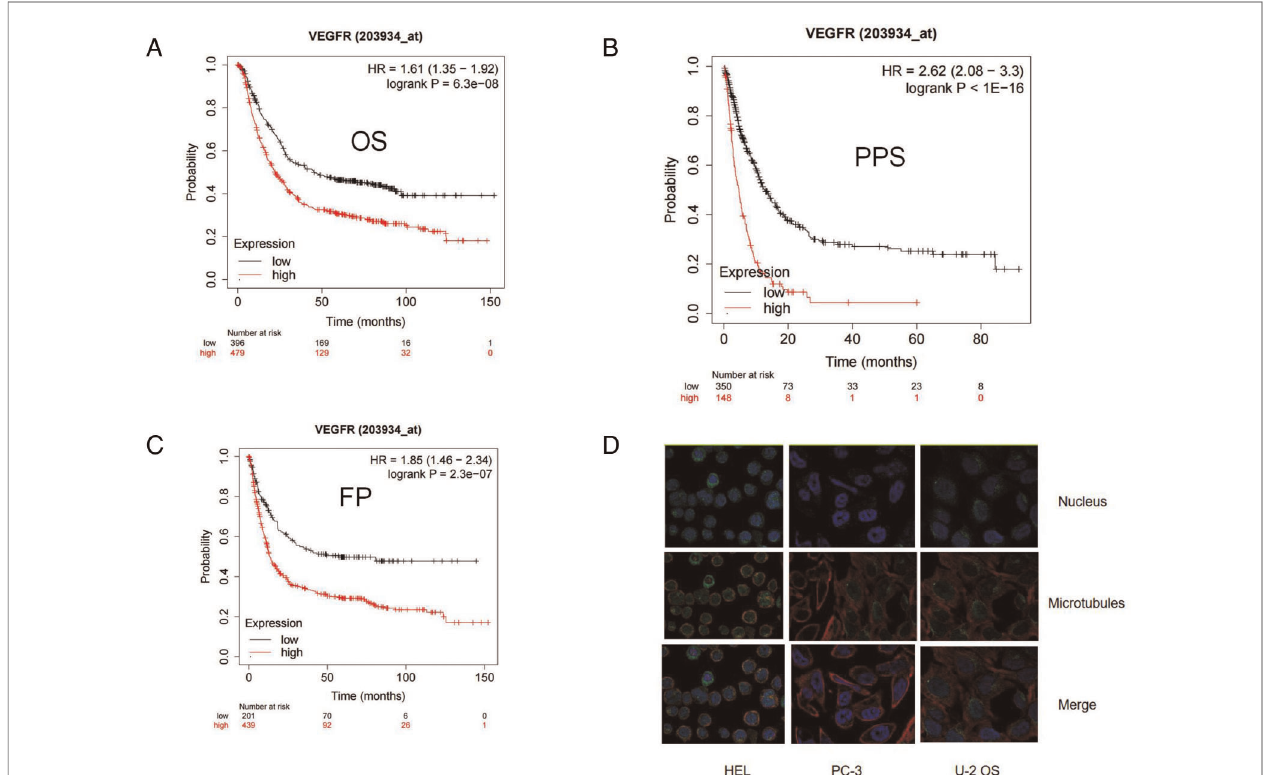
FIGURE 3 | High expression of VEGFR indicated a worse GC clinical prognosis from Kaplan Meier Plotter. ( A - C ) Kaplan Meier survival curve showed the relationship between PARP and overall survival (OS), post-progression survival (PPS), and fi rst progression survival (FP) in GC patients. ( D ) The location of VEGFR in